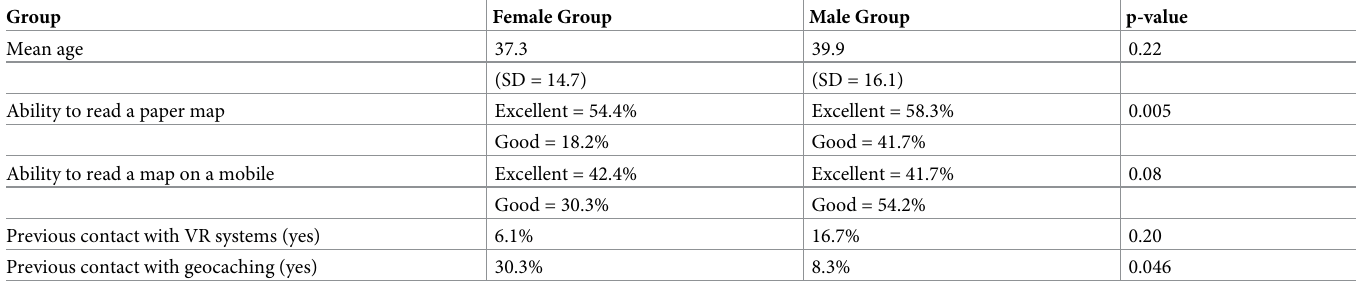
For comparison between the Female and Male groups, p-values are provided. SD = standard